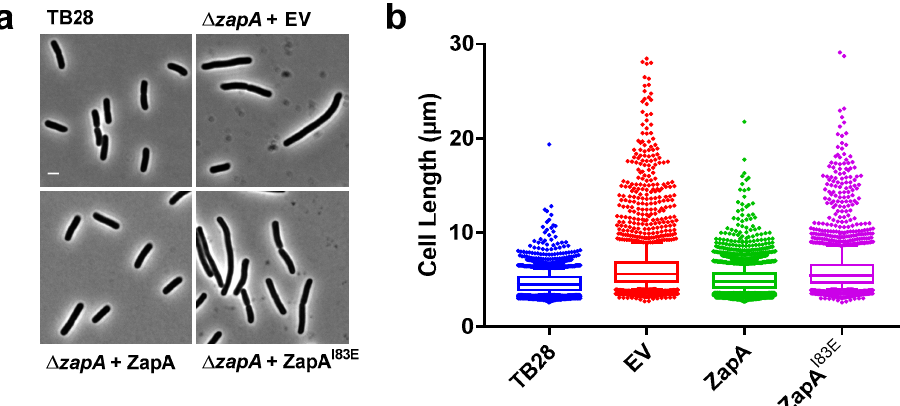
Figure 1. ZapA I83E does not complement the elongated ∆ zapA phenotype. ( a ) Phenotypes of the cells. The scale bar represents 2 µm. ( b ) Cell length distributions of each group. The number of cells and their average length measured were for the wild-type parental strains TB28; 3670 and 4.5 µm, EV; 2686 and 6.4 µm, from plasmid-expressed ZapA WT ; 4476 and 5.1 µm and ZapA I83E ; 2491 and 6.1 µm, respectively. The whiskers represent the 10th and 90th percentile.